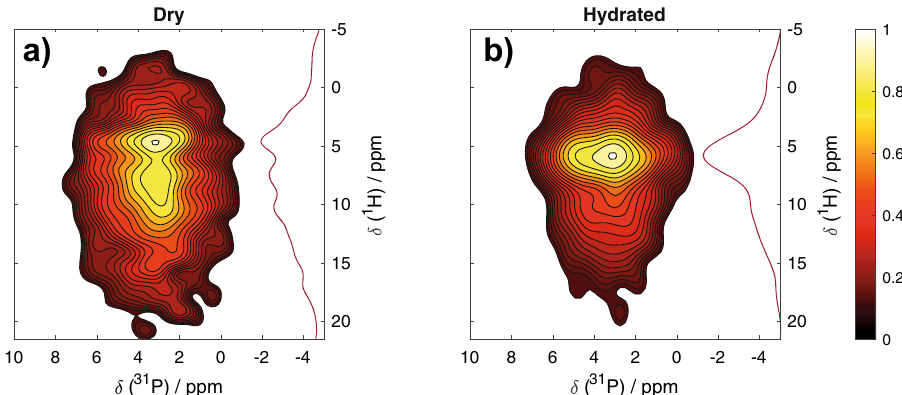
Fig. 6 1 H – 31 P heteronuclear correlation solid-state NMR spectra of D. tenuis brachiopod shell samples. Shown are changes in the chemical structure of the atmospherically dry shell ( a ) upon hydration ( b ). The correlation degree follows a normalized color map ranging from red to white (0 –